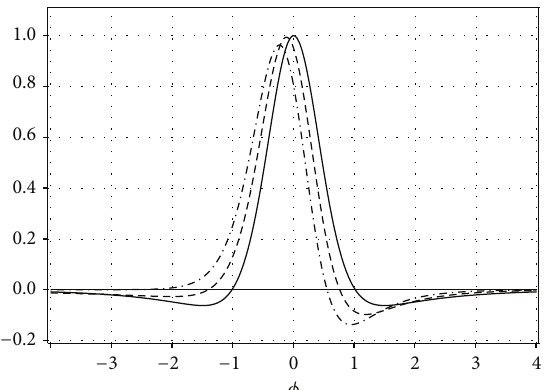
Figure 3: The energy density given by (14) for 𝑐 = 0 (solid line), 𝑐 = 2/3 (dashed line), and 𝑐 = 4/3 (dot-dashed line).